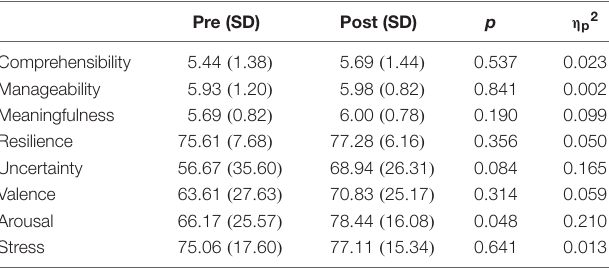
TABLE 3 | Descriptive statistics of the dependent variables from pre and post workshop, including univariate test results. Pre (SD) Post (SD) p η